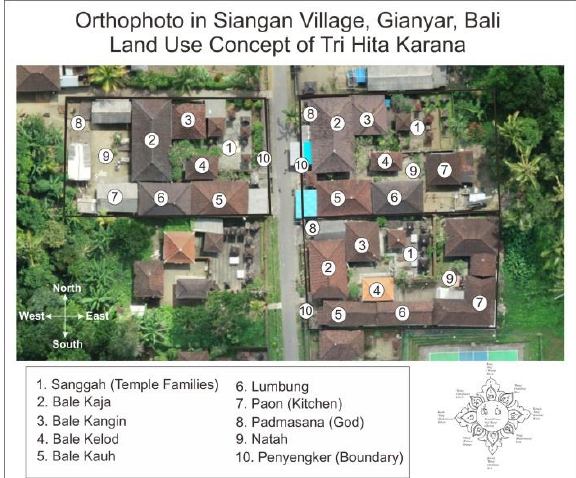
Figure 5. Result Orthophoto in Siangan